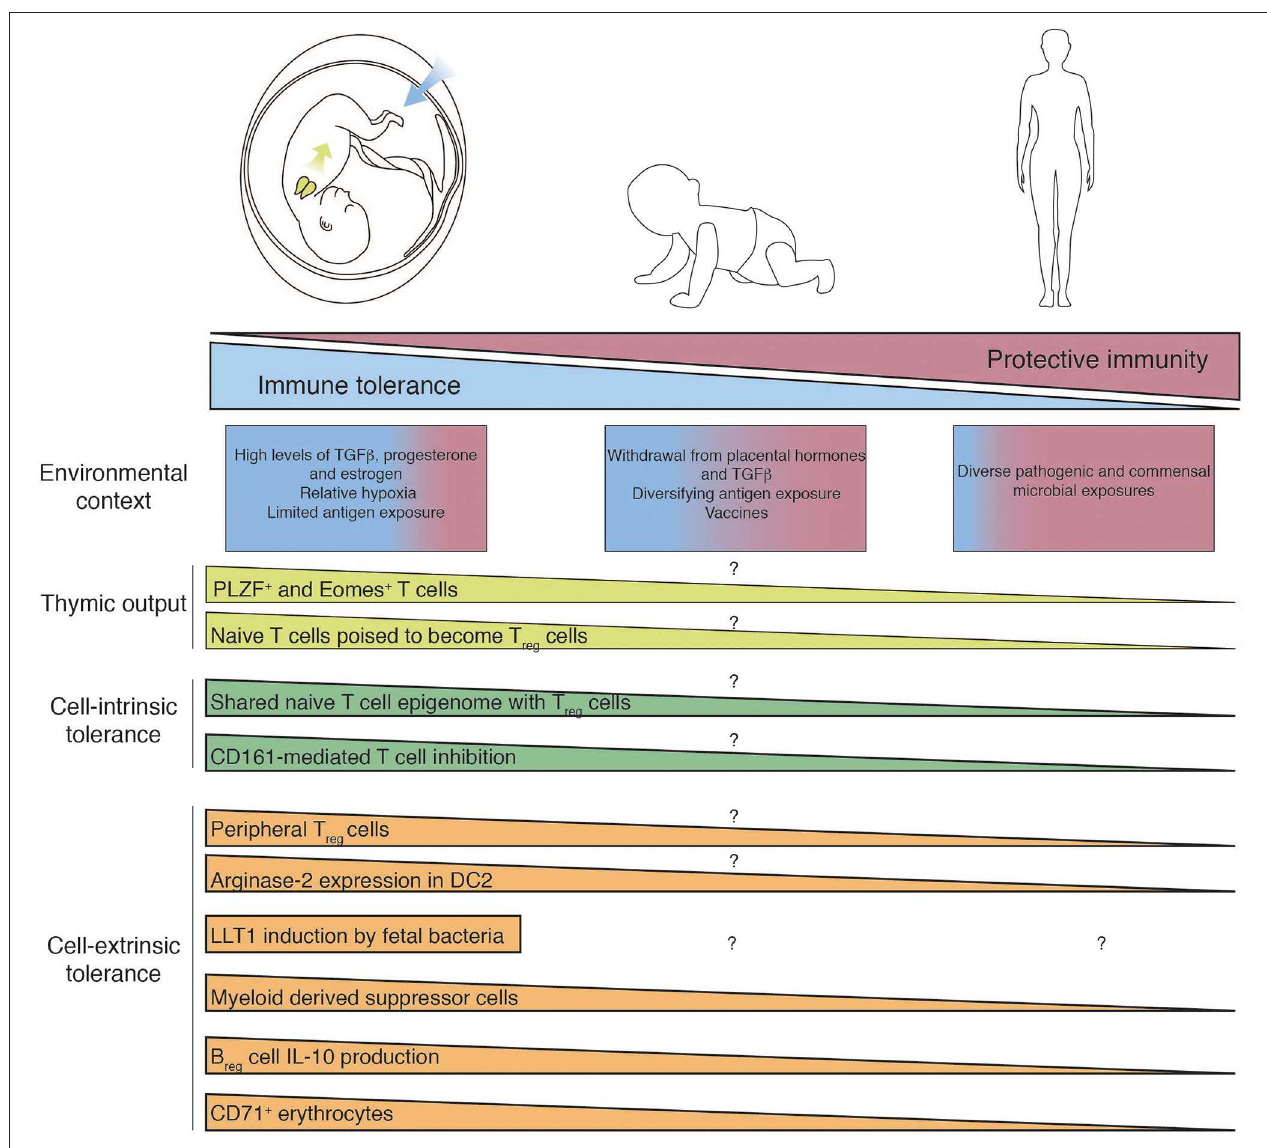
FIGURE 1 | Mechanisms of fetal T cell tolerance and immune regulation. Recent thymic emigrants populate the periphery and encounter tissue-specific environments which differ between fetal, infant, and adult. T cell differentiation and function are governed by diverse cell-intrinsic and -extrinsic mechanisms of immune regulation, which are subsequently lost as in utero pressures for tolerance give way to the need for post-natal protective immunity. Question mark indicates features of immunity that have yet to